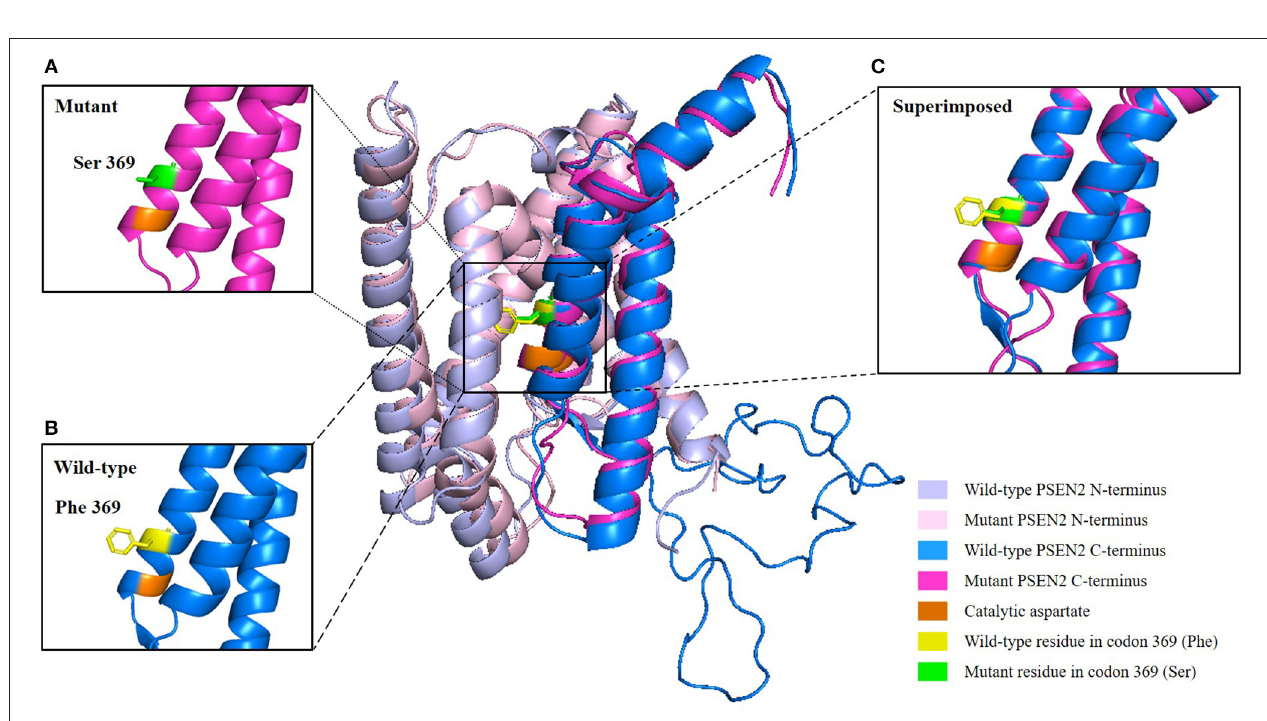
FIGURE 2 | Brain magnetic resonance imaging (MRI) slice-corresponding comparison of the proband for 3 years. Arrows point at progressive atrophy of temporal lobe and hippocampus. A1–A3, B1–B3, and C1–C3 were scanned in August 2018 (2 years after dementia symptom onset in this proband); A4–A6, B4–B6, and C4–C6 were scanned in July 2019; and A7–A9, B7–B9, and C7–C9 were scanned in July 2020. (A) Axial T1WI: each column revealed progressive atrophy of the left-dominant bilateral temporal lobe and hippocampus. (B) Left-side sagittal T1WI: focused on the left part of the hippocampus. (C) Right-side sagittal T1WI: focused on the right part of the hippocampus.